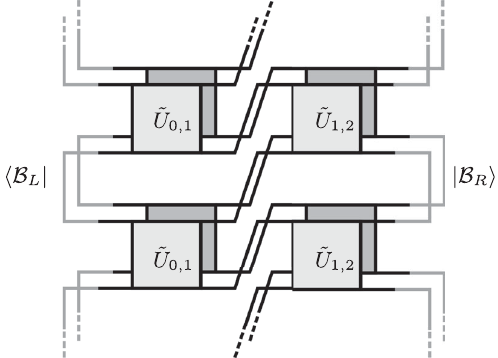
FIG. 9. SFF with open boundary conditions in terms of the transfermatrix(for t ¼ 2 and L ¼ 3 sites), K ð t Þ ¼ h B L j T 0 ; 1 T 1 ; 2 j B R i . The vectors j B L;R i encode the boundary